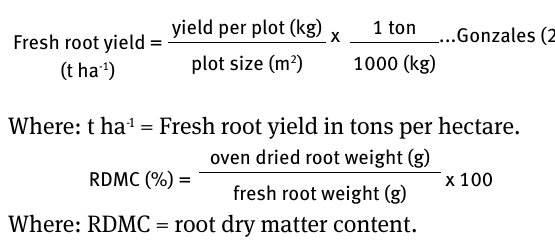
pale yellow, 5 = dark yellow, 6 = pale orange, 7 = intermediate orange, 8 = dark orange, 9 = strongly pigmented with